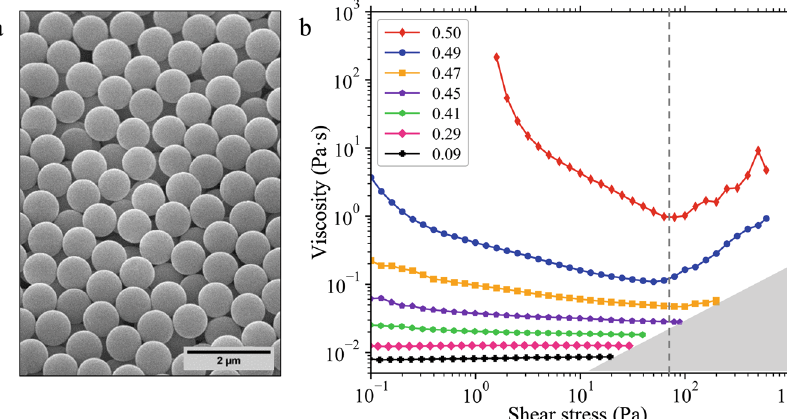
Fig. 1 Rheology of the colloidal suspensions. a SEM image of the colloidal silica spheres used in our drop impact experiments; the sphere diameter is 830 ± 20 nm. b Bulk rheological fl ow curves: the colloidal suspension exhibits viscous fl ow, shear thinning, and shear thickening as ϕ is increased. The grey triangle in the bottom right indicates the rate limit of the rheometer.